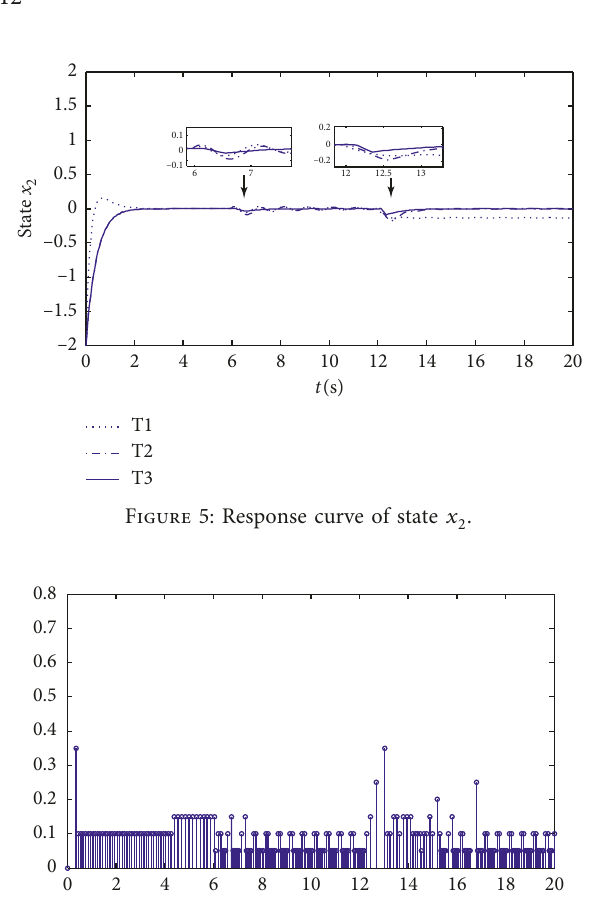
Figure 6: Transmission time and transmission interval diagram of NCS under